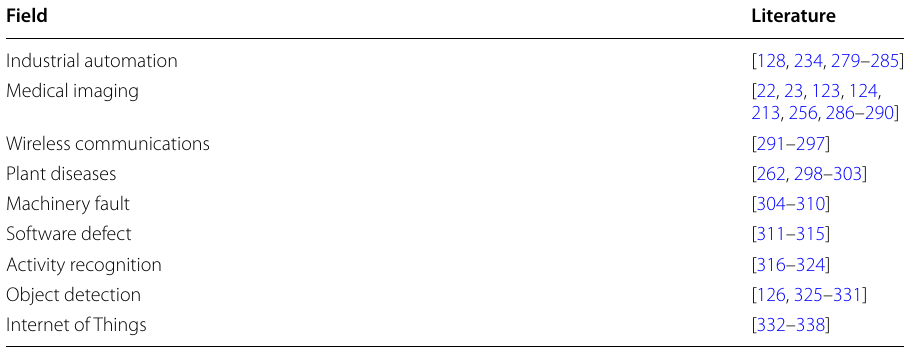
Table 1 Some examples of TL from the